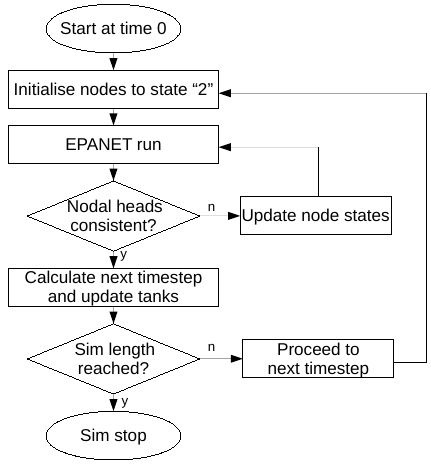
Figure 2. Diagram of PDD model